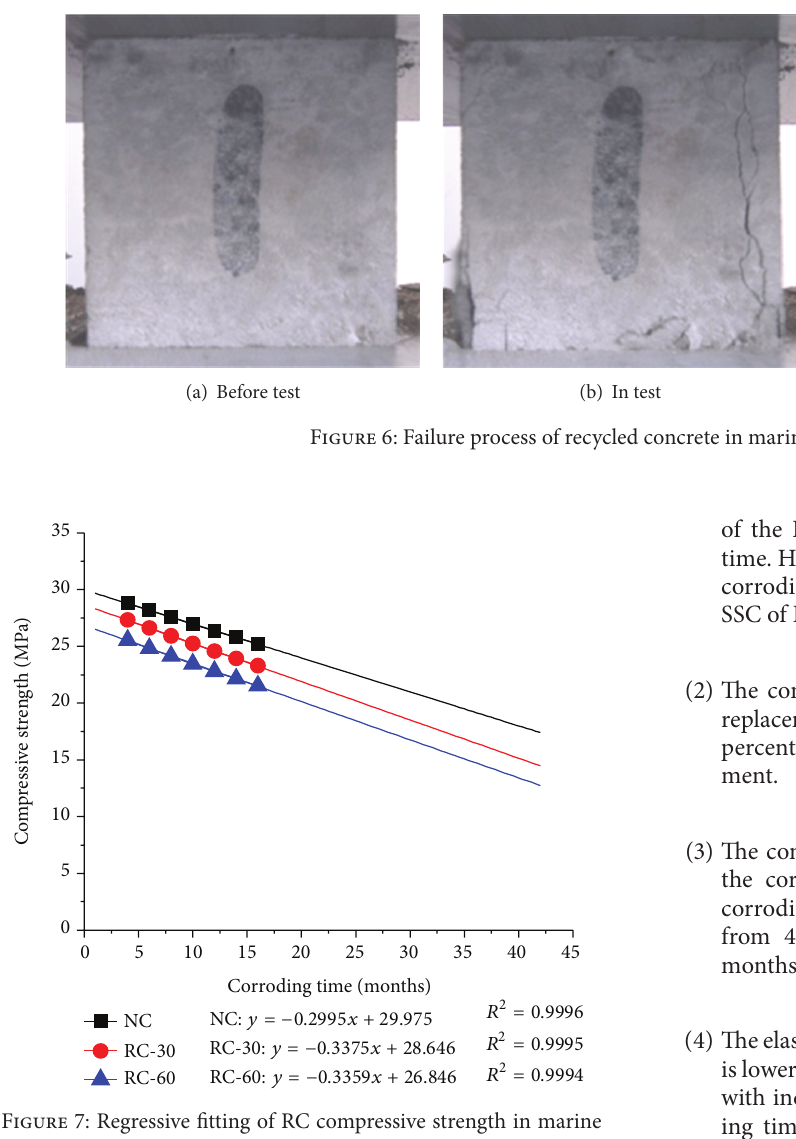
Figure 7: Regressive fitting of RC compressive strength in marine